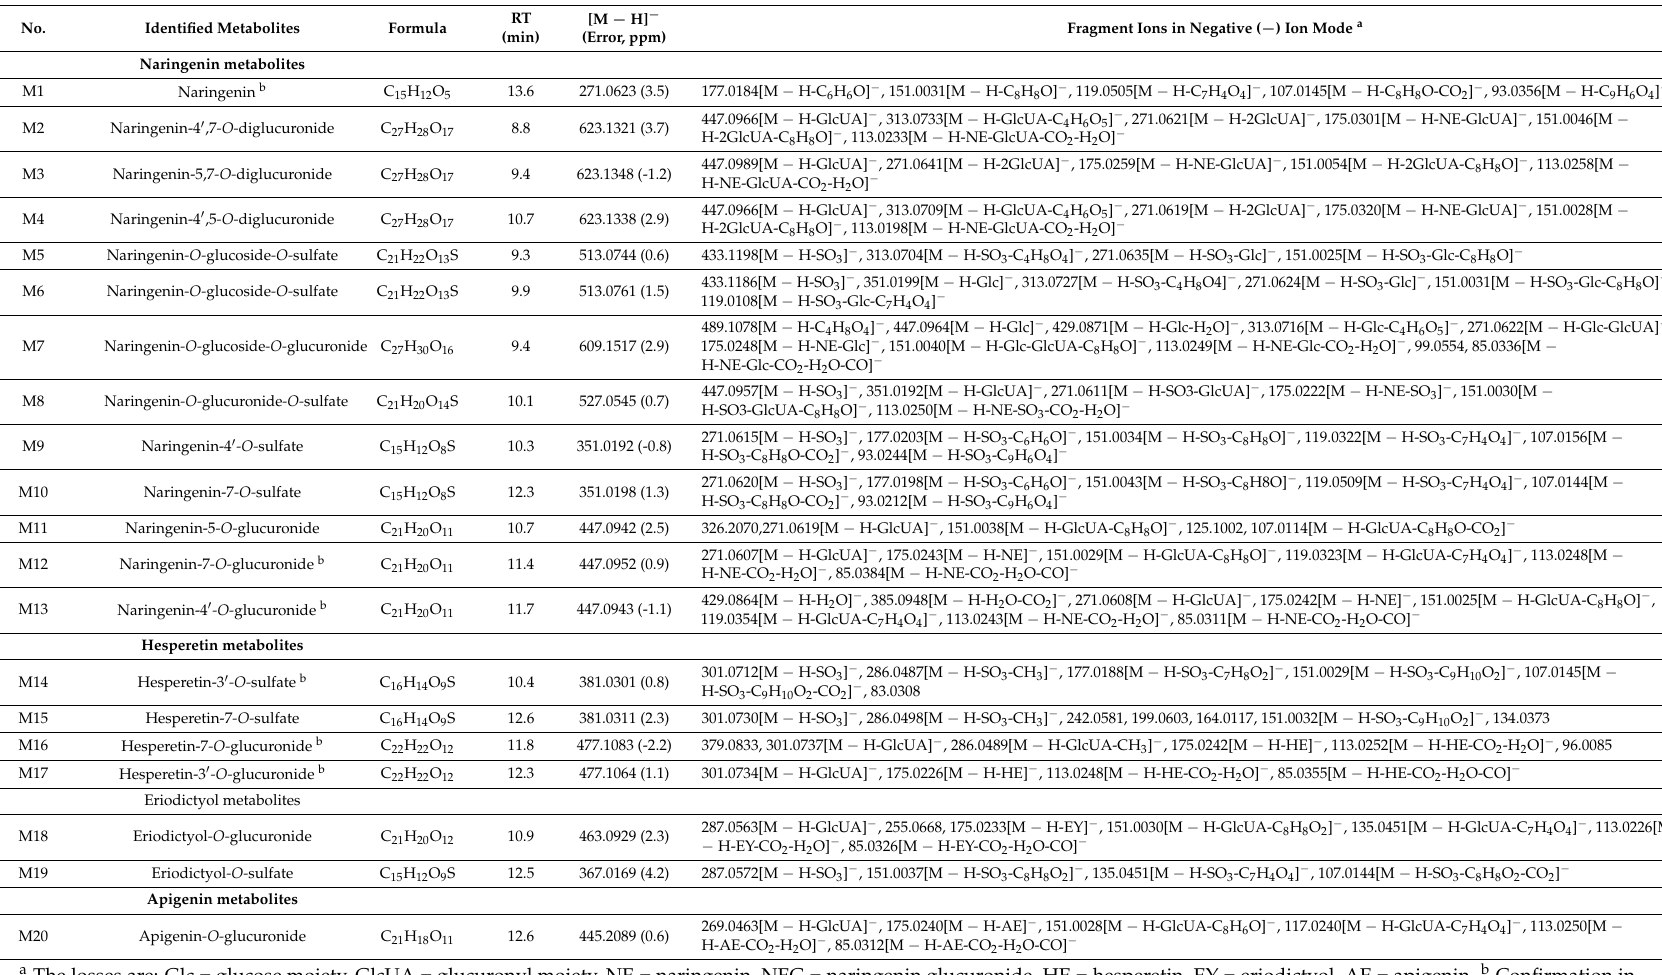
Table 2. Identification of flavonoid metabolites in human urine after the consumption of 250 mL ECG extract by